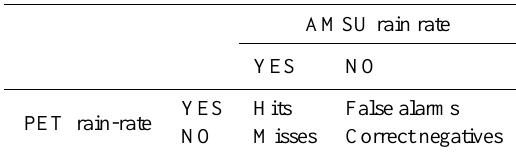
Table 3. Contingency table for the definition of statistics indexes POD, FAR, CSI, Bias and